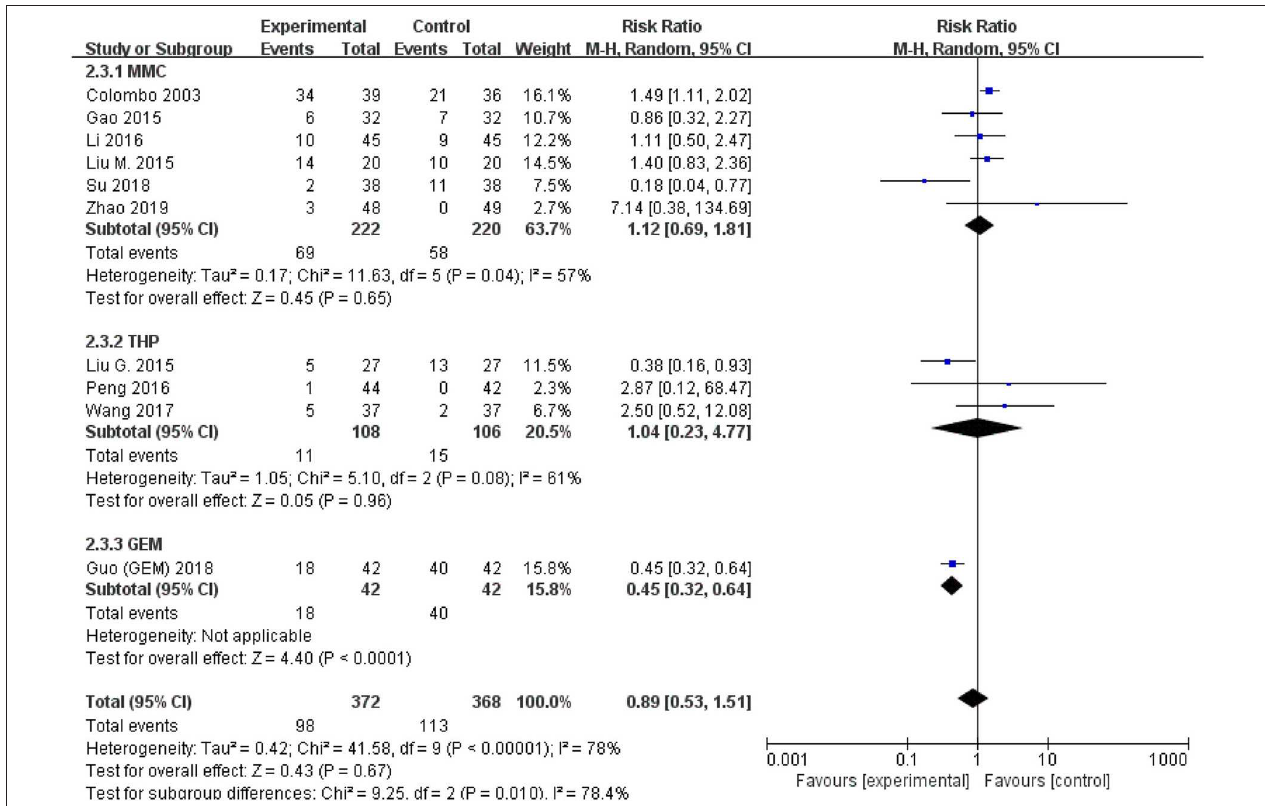
FIGURE 9 | Comparison on adverse event rate between thermal intravesical chemotherapy and normal temperature intravesical chemotherapy after subgroup analysis stratified by chemotherapeutic agent used in thermal intravesical